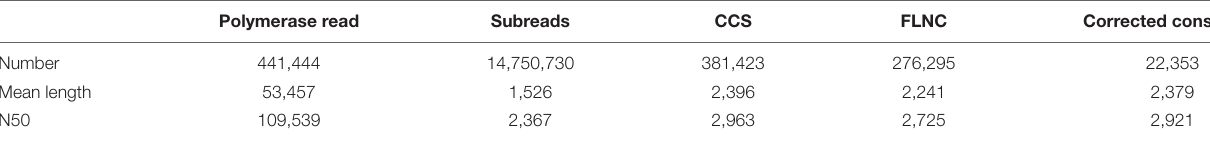
TABLE 1 | Summary of reads from PacBio SMRT sequencing.